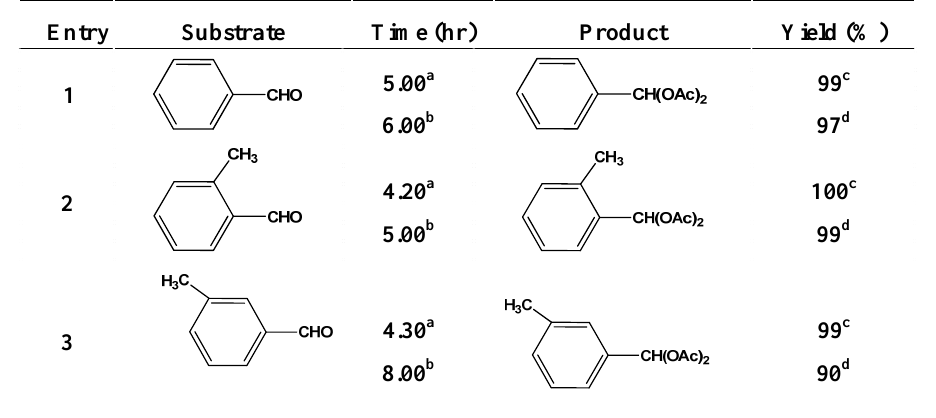
Table 2. Aldehydes protection under solvent-free